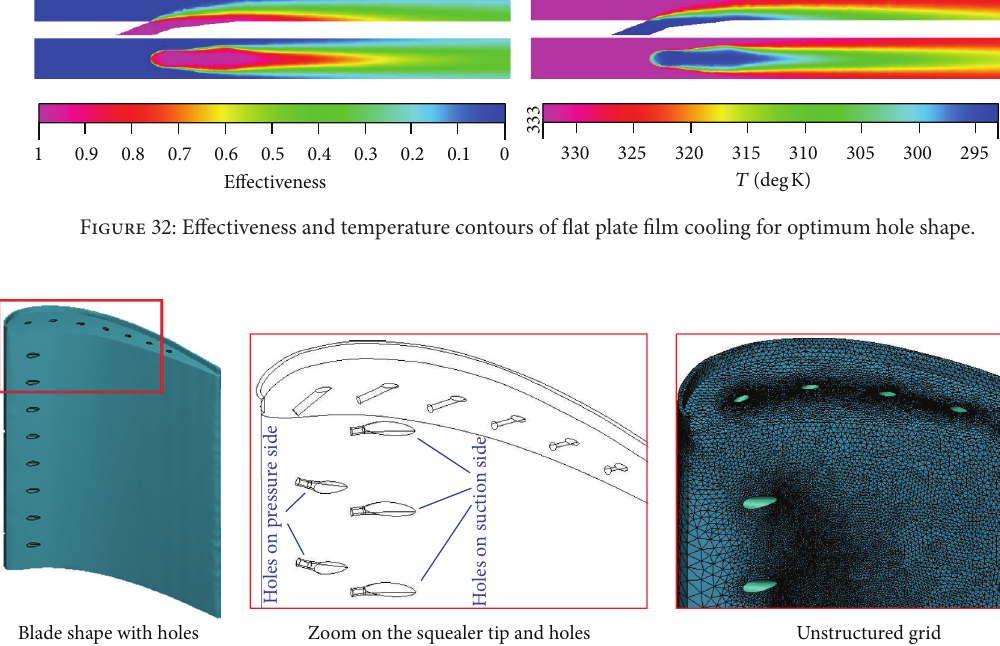
Figure 33: Actual turbine blade with LFDSA hole shape and blade unstructured grid.